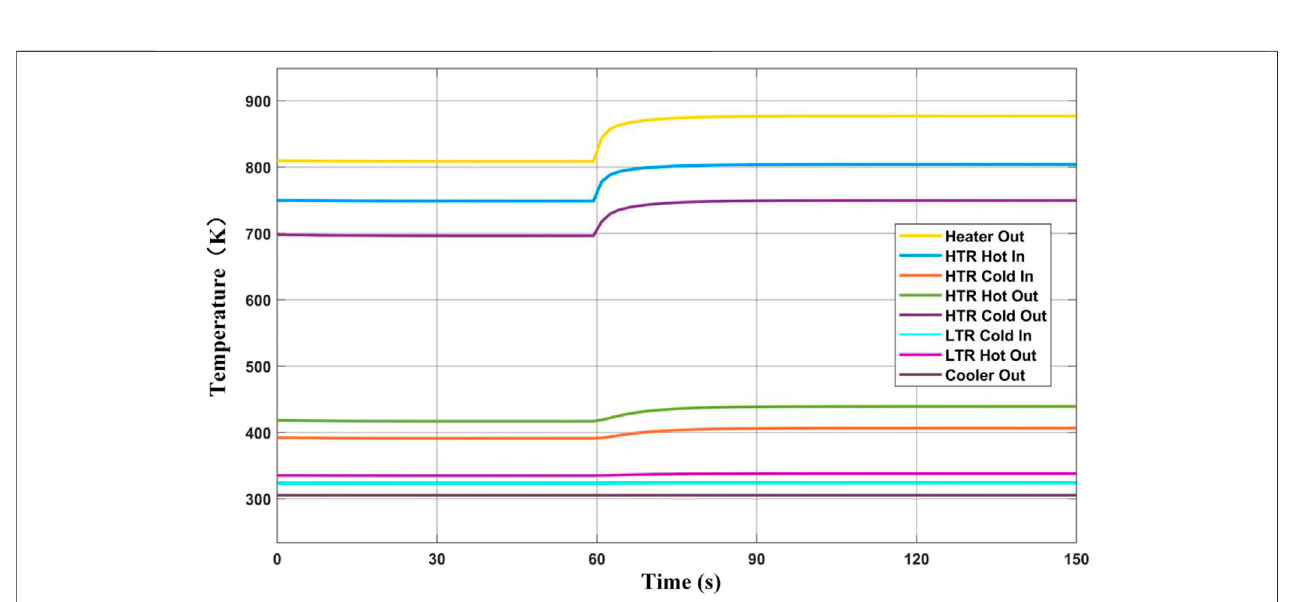
FIGURE 7 | Dynamic response of cycle temperature while increasing heat source